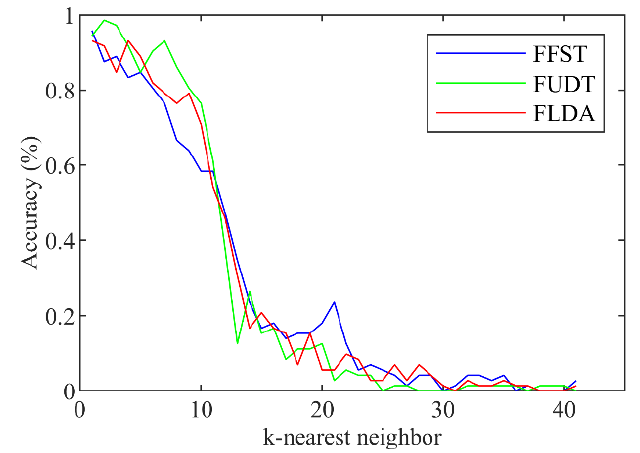
Figure 7. The accuracy rates on the test set when changing the value of k.